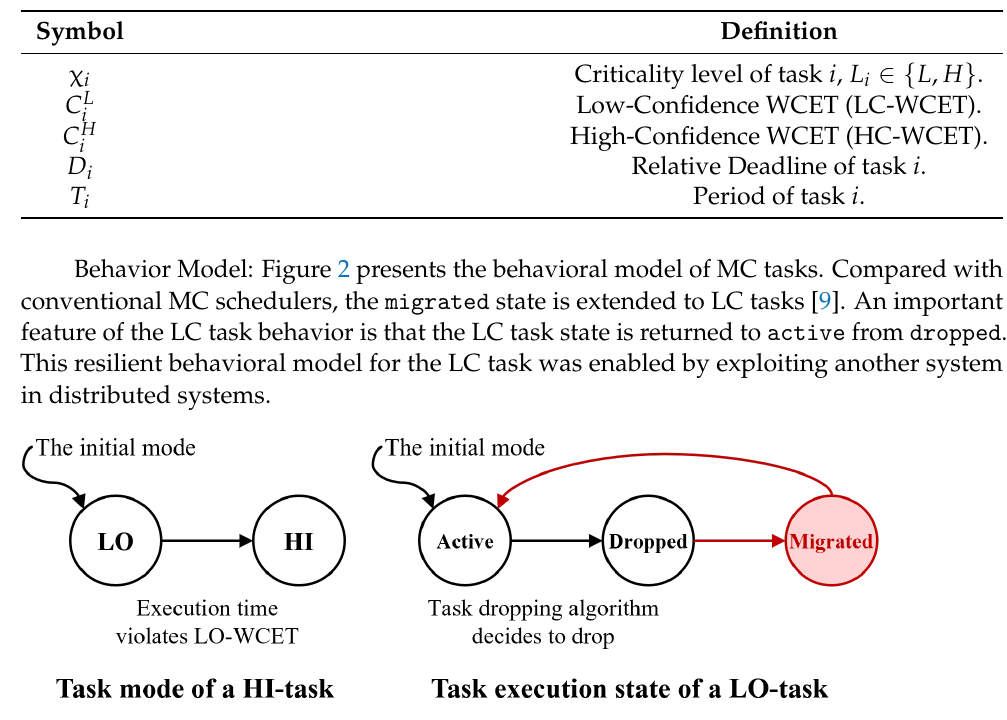
Table 1. Task model for MC schedulers.